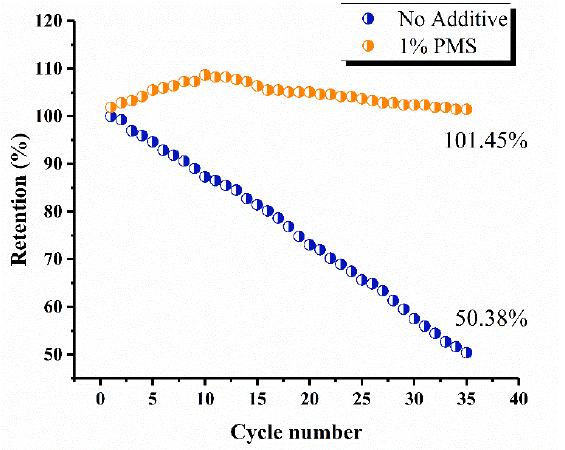
Figure 8. Discharge capacity retention of Li/graphite half-cells without and with PMS after 35 cycles 1 C in a voltage range of 0.001–3